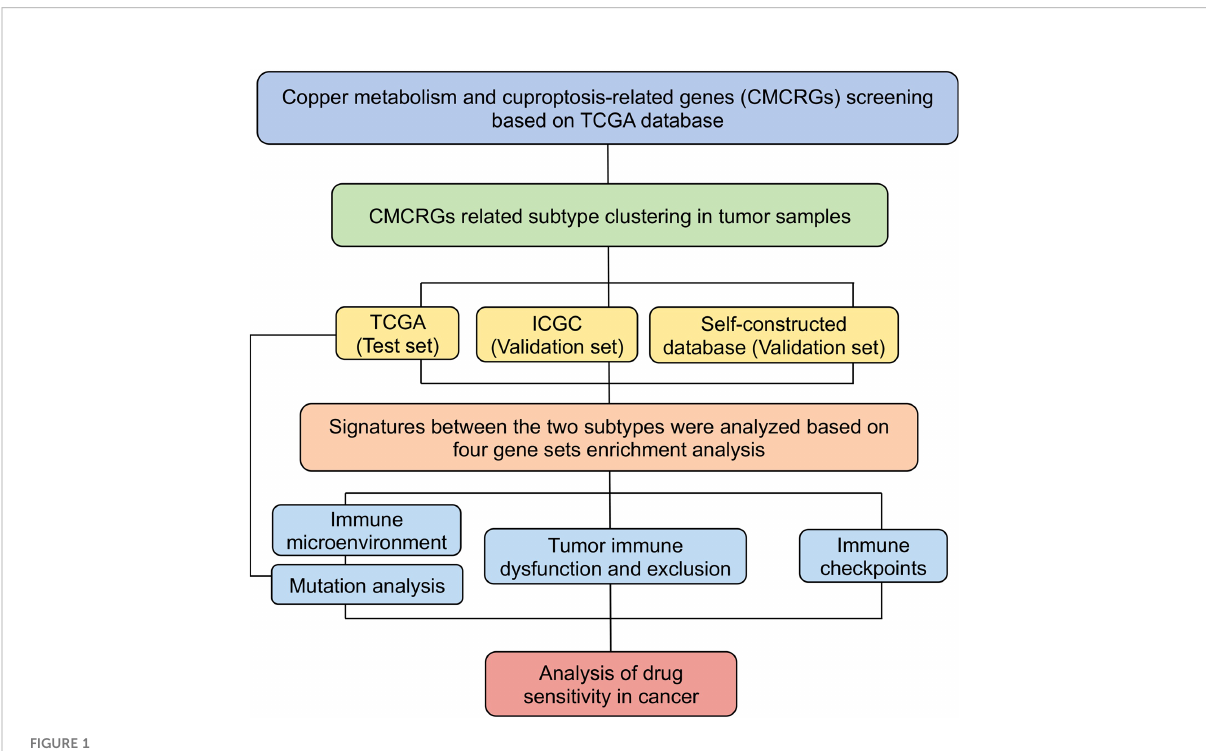
FIGURE 1 Flow chart of this